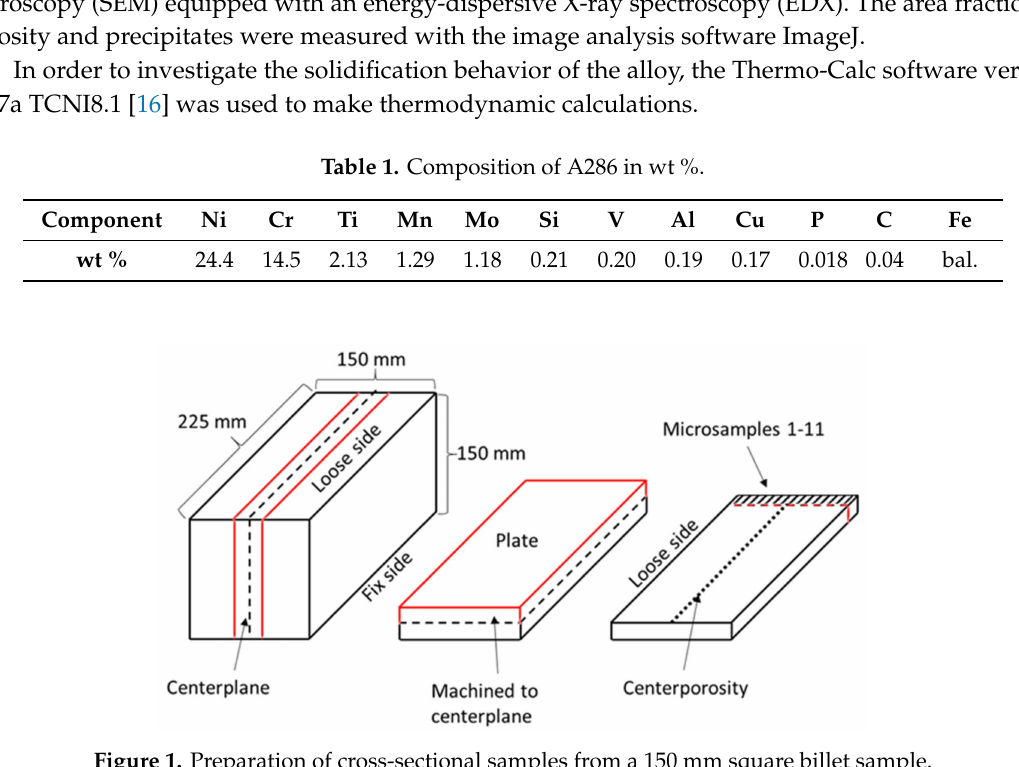
Figure 1. Preparation of cross-sectional samples from a 150 mm square billet